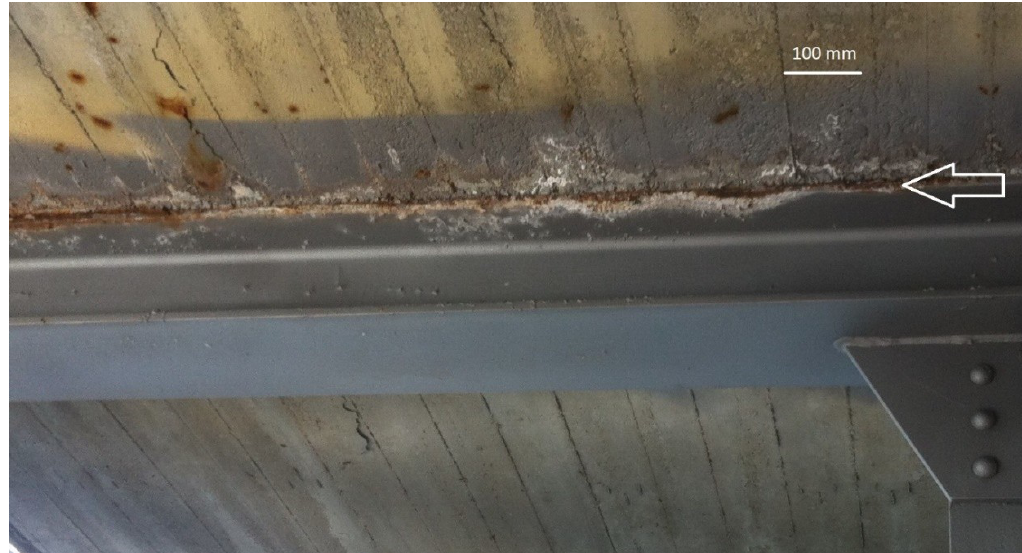
Figure 7. The saponification of alkyd paint where the painted H-beam is in contact with the concrete (marked with an arrow) and subsequent corrosion of zinc and steel.